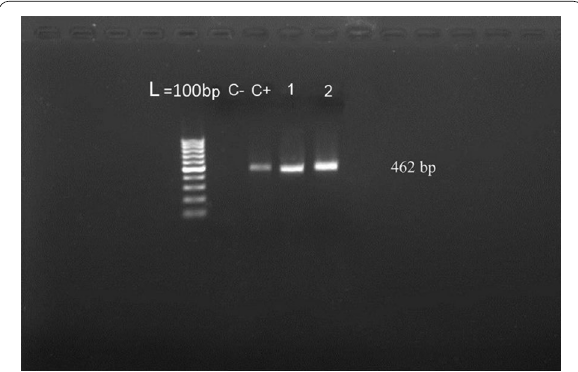
Fig. 1 Electrophoresis of PCR amplification (462 bp) provided from liver of sheep sample (lane C lane 1 and 2 positive samples, L ladder 100